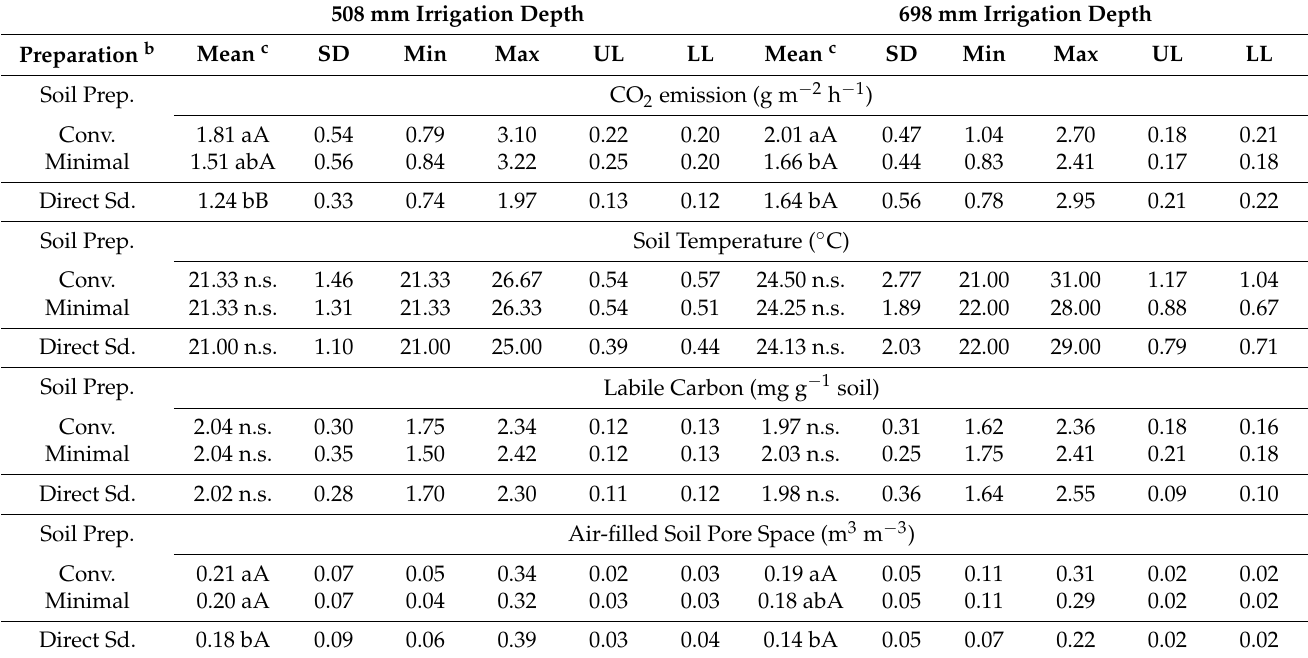
Table 3. Descriptive statistics a of CO 2 efflux, soil temperature, air-filled soil porosity and labile carbon in the 0–0.20 m soil layer for irrigation depths of 508 and 698 mm and differing soil preparation methods averaged over 2011 and 2012 wheat crop dry